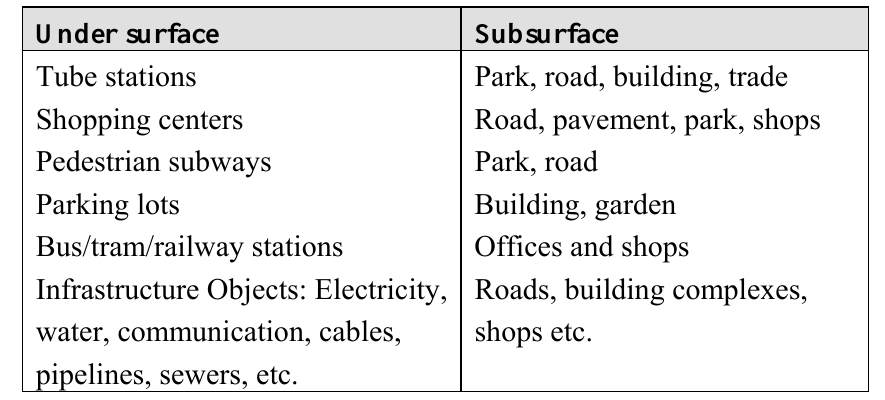
Table 2. The usage of underground and its surface structures according to their intended